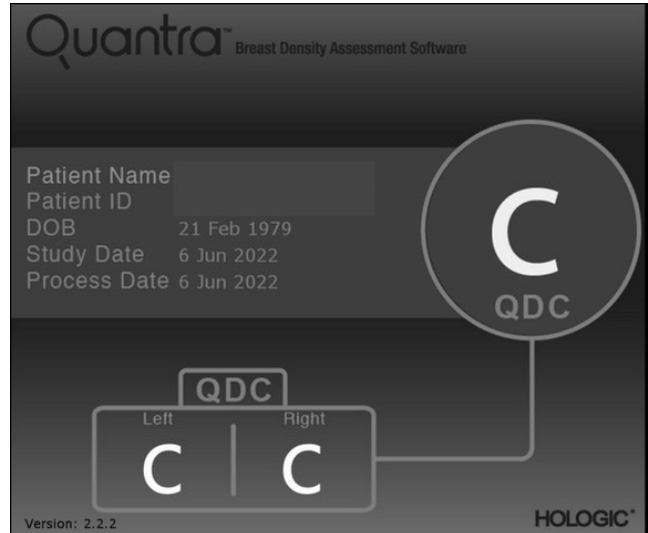
Figure 3. Quantra (HOLOGIC) automated detection of BD according to BI-RADS classification, classified as C in both breasts. The automatic assessment of BD refers to the mammography in Figure 4. QDC: Quantra density